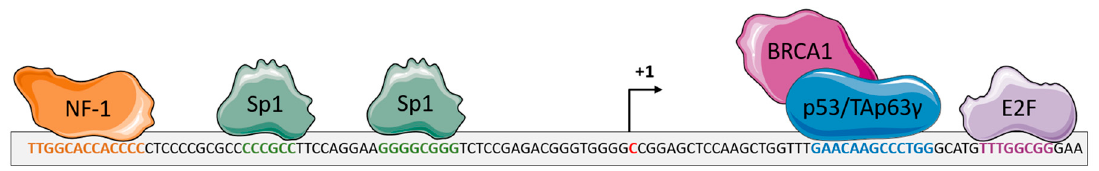
Figure 1. Schematic representation of the regulation of the gene encoding the DDB2 (Damage-specific DNA-binding protein 2) protein. The proximal promoter of ddb2 gene harbors response elements for the transcription factors NF-1 (Neurofibromin 1) (orange) and Sp1 (Transcription factor Sp1) (green) upstream of the transcription initiation site. The proximal promoter also contains a response element for p53, in association with BRCA1 (Breast cancer type 1 susceptibility protein), or Tap63 γ (Tumor protein 63 isoform gamma) (blue) proteins and the E2F (Transcription factor E2F) transcription factor downstream of the transcription initiation site. The binding of these proteins leads to the regulation of ddb2 gene expression.